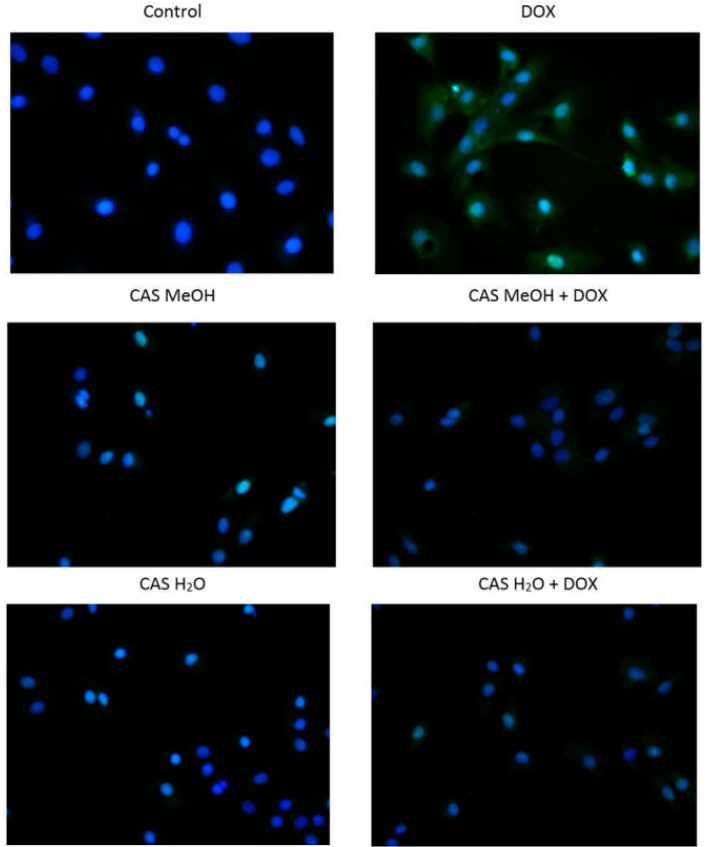
Figure 5. Detection of oxidative stress in H9c2 cells using CellROX Green Reagent. Cells were treated for 48 h with 2 µM of DOX and 125 µg/mL of CAS H 2 O or 125 µg/mL of CAS MeOH, or a